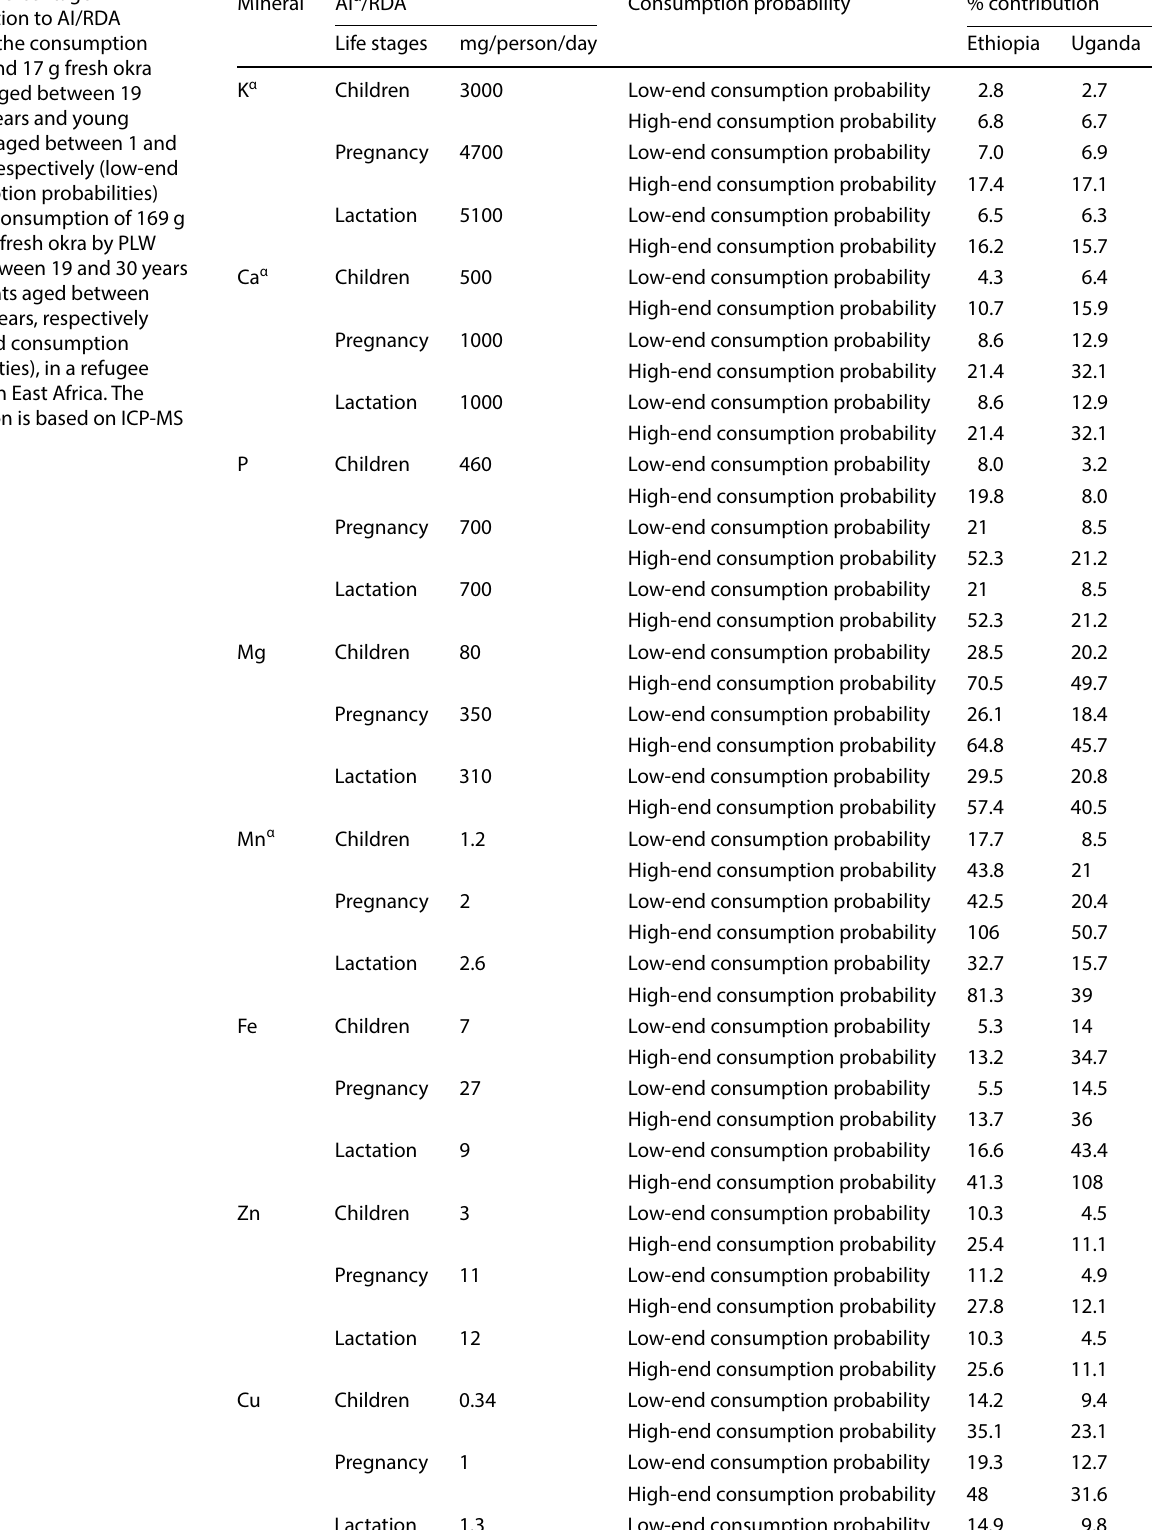
Table 2 Percentage contribution to AI/RDA through the consumption of 68 g and 17 g fresh okra by PLW aged between 19 and 30 years and young children aged between 1 and 3 years, respectively (low-end consumption probabilities) and the consumption of 169 g and 42 g fresh okra by PLW aged between 19 and 30 years and infants aged between 1 and 3 years, respectively (high-end consumption probabilities), in a refugee context in East Africa. The estimation is based on